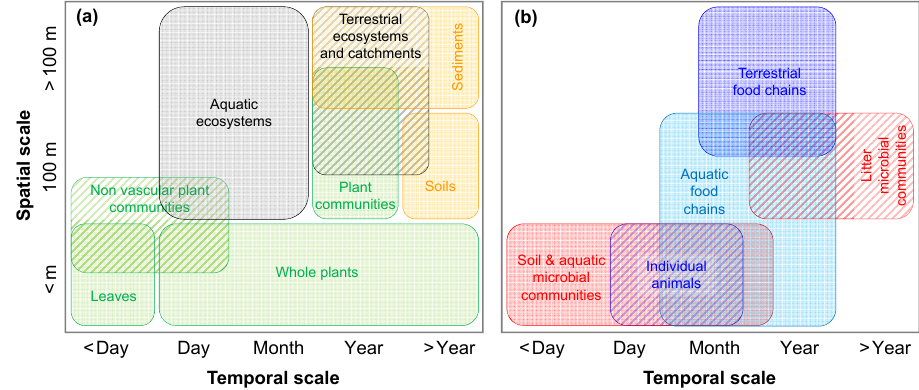
Figure 3. Illustration of typical spatial and temporal scales at which C fluxes are calculated to estimate CUE (or CSE) in various subsystems. (a) Scales typical of observations of vegetation, whole ecosystems, and soils and sediments; (b) scales typical of observations of heterotrophic organisms and food chains. Colour codes are as in Fig.